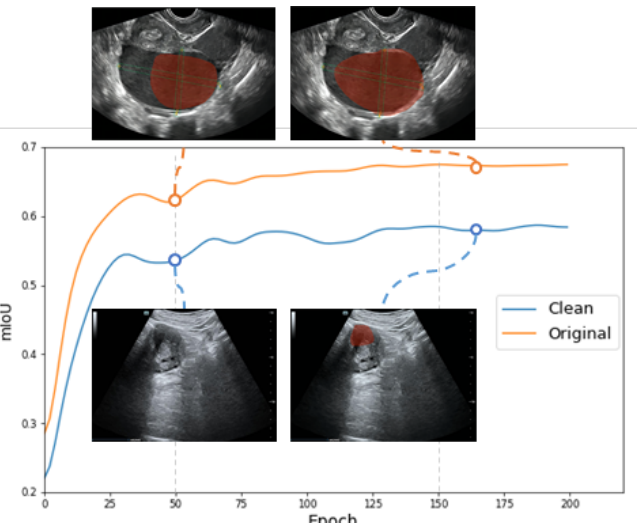
Figure A1. The accuracy graph of lesion segmentation of the PSPnet [47] model. The blue line represents the accuracy of using the clean images as the testing set. The yellow line represents the accuracy of using the original images with symbols as the testing set. The figure also shows a visualization of the segmentation results for the 50th and 150th epochs.